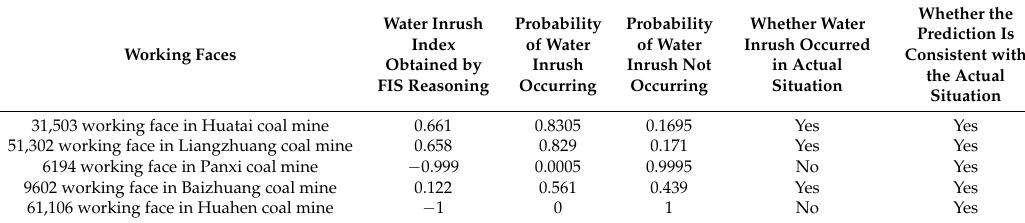
Table 3. Prediction results of the five tested working